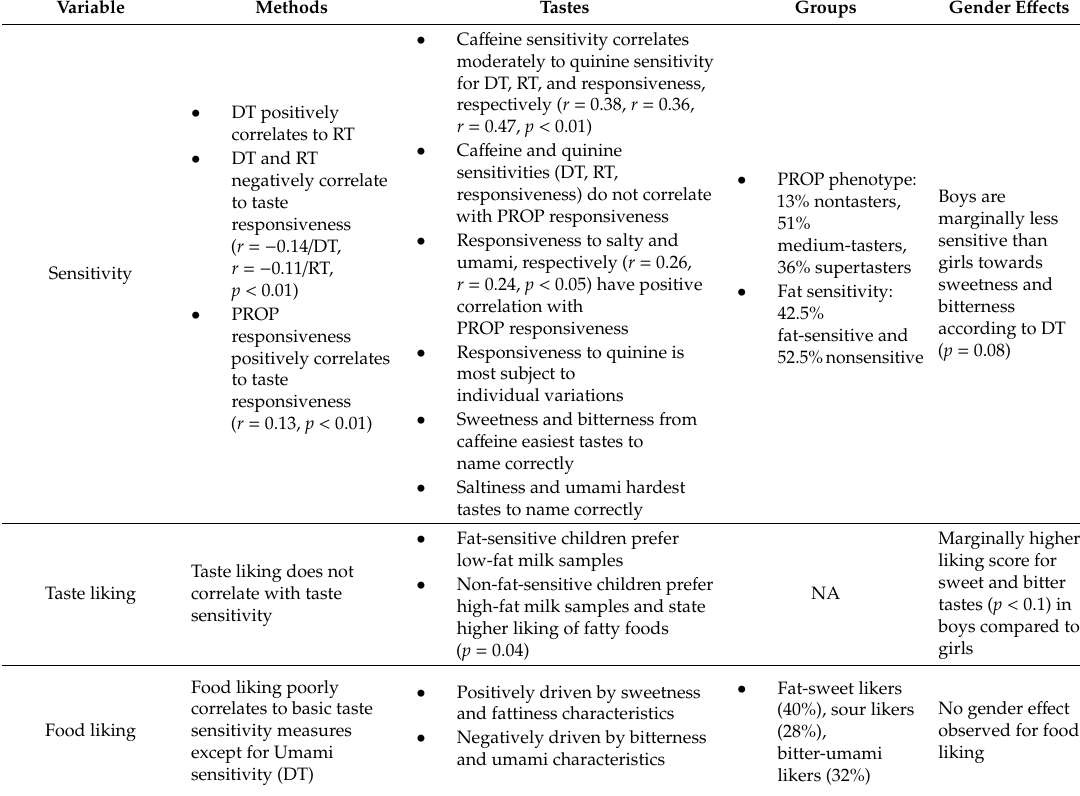
Table 6. Overview of key findings across measurement approaches and taste